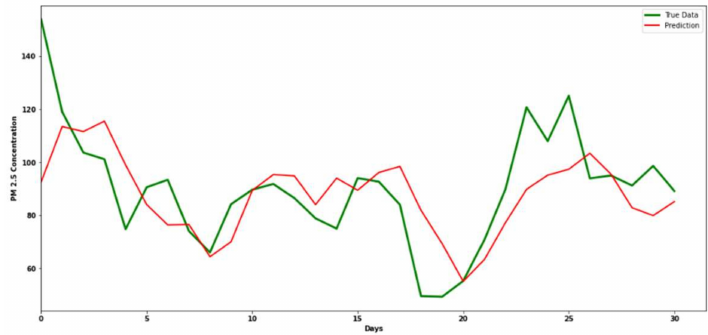
Figure 18. Forecasting for the next month for Islamabad using the LSTM encoder–decoder model.